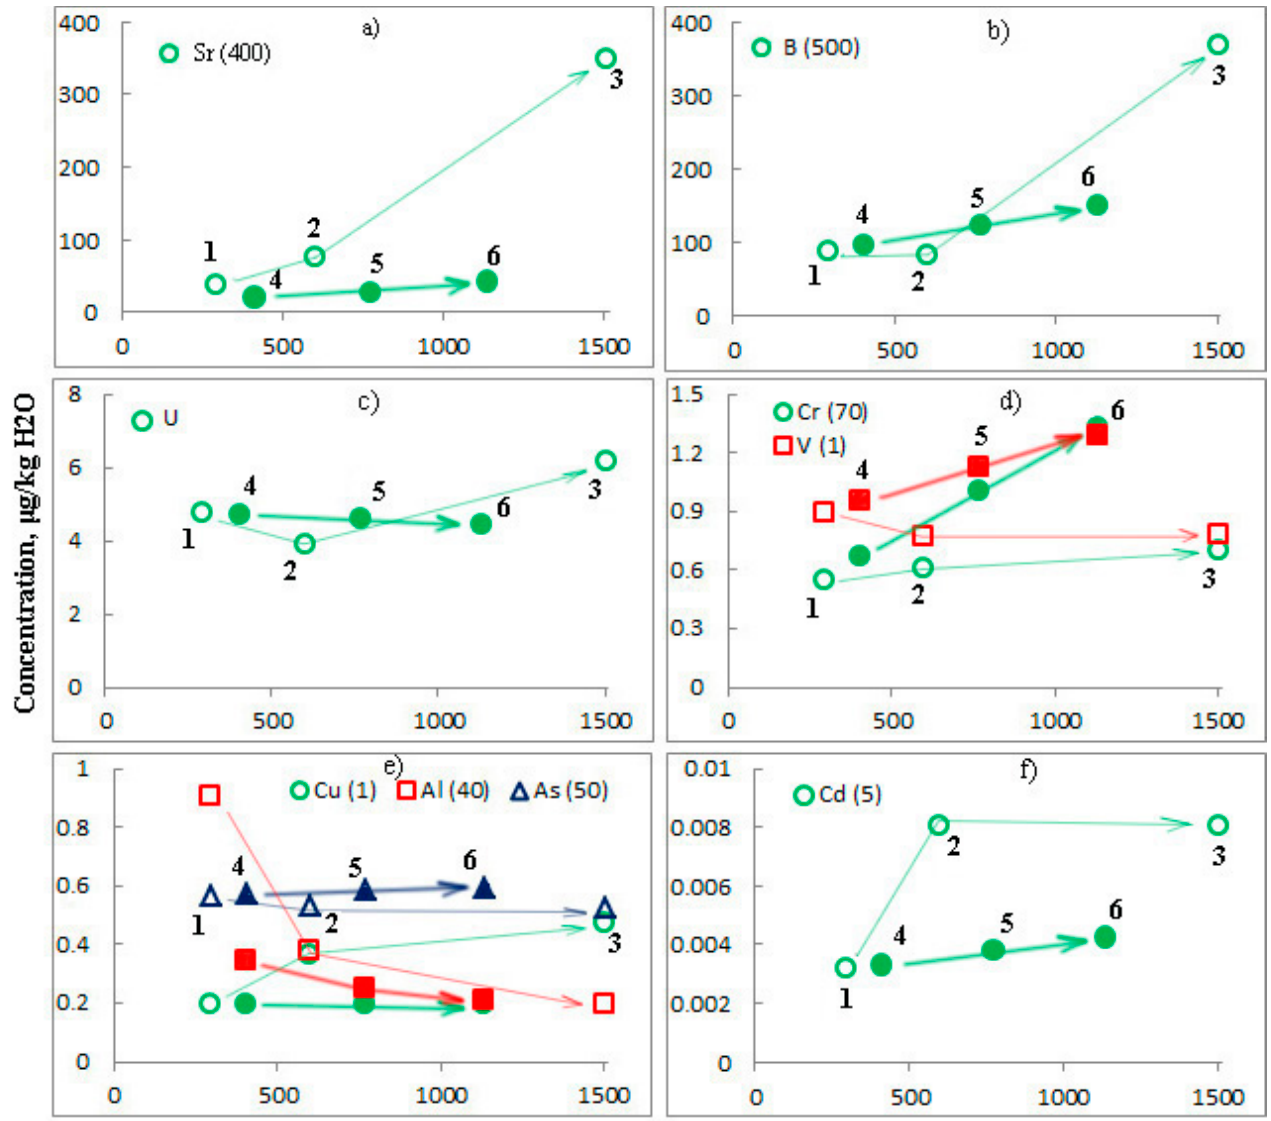
Figure 6. Dependence of changes in concentrations of trace elements in obtained solutions ( a ) Sr; ( b ) B; ( c ) U; ( d ) Cr and V; ( e ) Cu, Al and As; ( f ) Cd according to Scenarios 1–3 (without filling marker) and 4–6 (complete filling of marker) from TDS of these solutions (see Tables 2 and 3). With a further increase in the TDS level in mixing solutions to 0.4–1.5 g/L according to Scenarios 2–6, the Cl concentration increases to 125–539 mg/L due to the process of mixing fresh water with brackish and salty water from lenses L1 and L2, as well as from the Vendian Mezen Formation aquifer. The composition of the water becomes